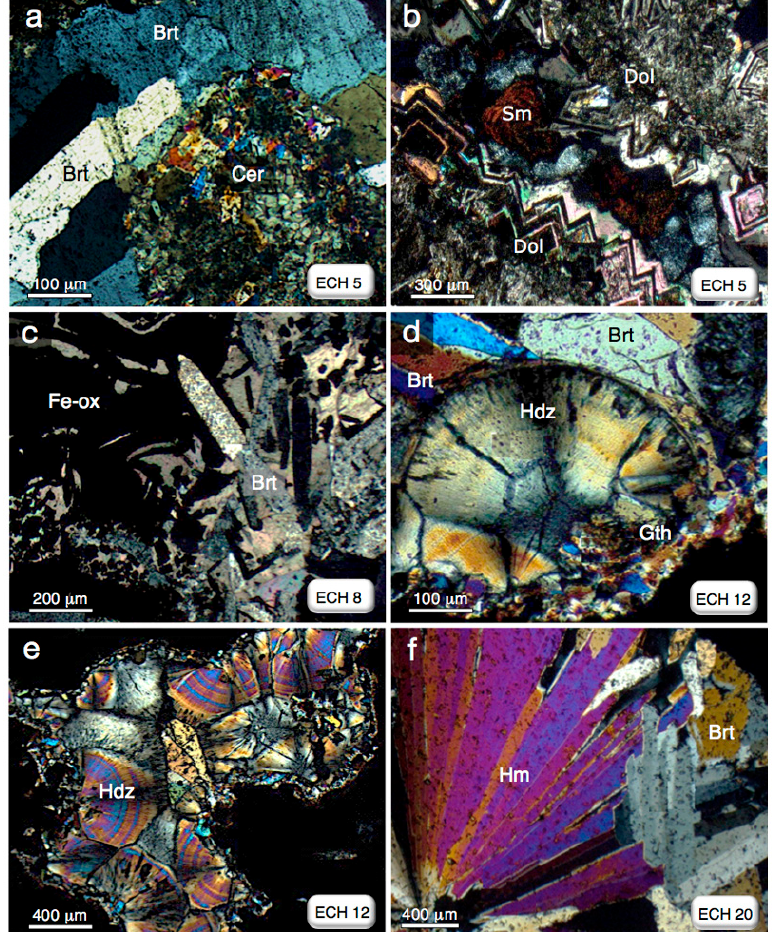
Figure 6. Micrographs of selected nonsulfide samples, observed in a thin section at polarizing microscope (N+). ( a ) Fine-grained cerussite among relic barite crystals. ( b ) Smithsonite as filling in dolomite. ( c ) Tabular barite with late goethite. ( d , e ) Botryoidal hydrozincite. ( f ) Euhedral hemimorphite crystals with relic barite. Brt: barite; Cer: cerussite; Dol: dolomite; Fe-ox: iron oxy- hydroxides (mainly goethite); Gth: goethite; Hdz: hydrozincite; Hm: hemimorphite; Sm: